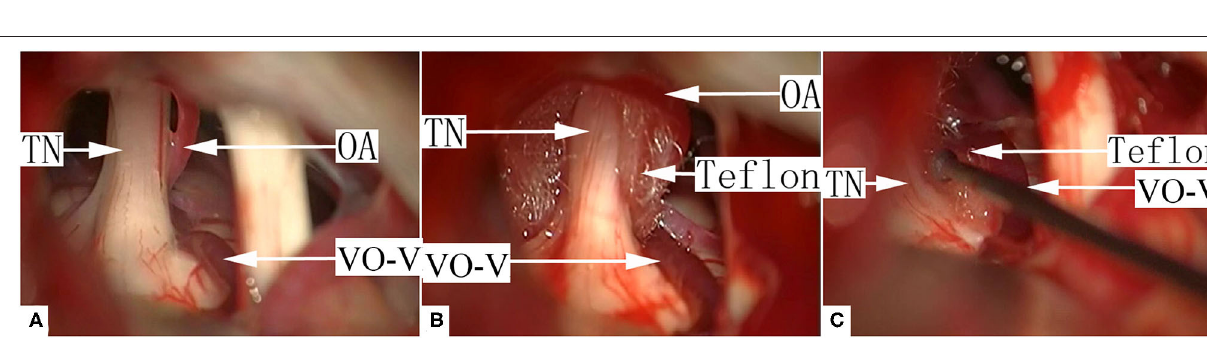
FIGURE 3 | A representative case of group I, type B VO-VREZ with relatively large diameter. (A) The VO-VREZ was lateral to the nerve root. (B) The VO-VREZ was dissected. (C) The nerve root was decompressed with shredded Teflon interposition. TN, trigeminal nerve; VO-V, venous offending on the ventral side of root entrance/exit zone; Teflon, shredded Teflon interposition.